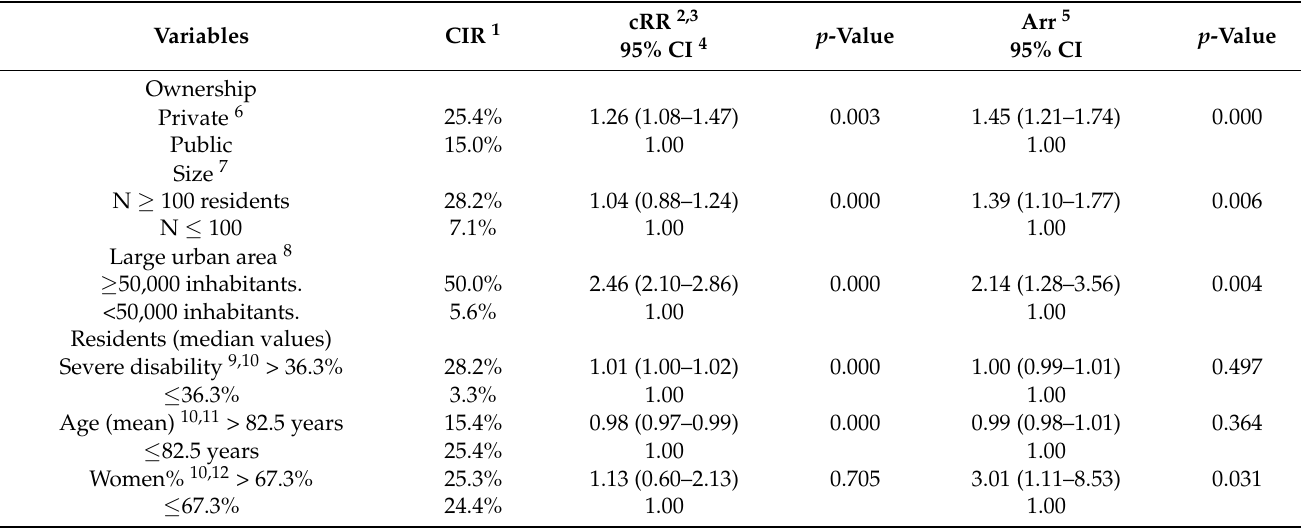
Table 3. Risk factors of the cumulative incidence rate (CIR) of COVID-19 in residents of nursing homes. Health Departments 2 and 3 of Castellon. March 2020–January 2021.